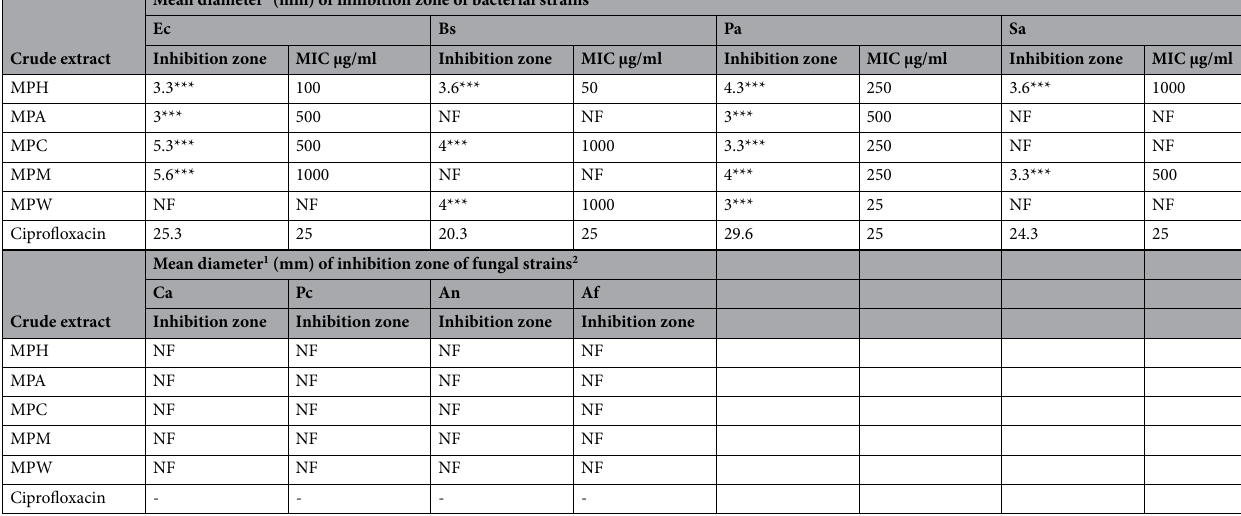
Table 4. Anti-microbial activity of various crude extracts of M. paniculata. 1 n = 3 Standard error was < 15% of mean in all cases, P value (***) represents very highly significant difference over the standard group. 2 Ec: Escherichia coli , Bs: Bacillus subtilis , Pa: Pseudomonas aeruginosa, Sa: Staphylococcus aureus , Ca: Candida albicans, Pc: Penicillium chrysogenum , An: Aspergillus niger and Af: Aspergillus flavus . 3 NF: Not found any